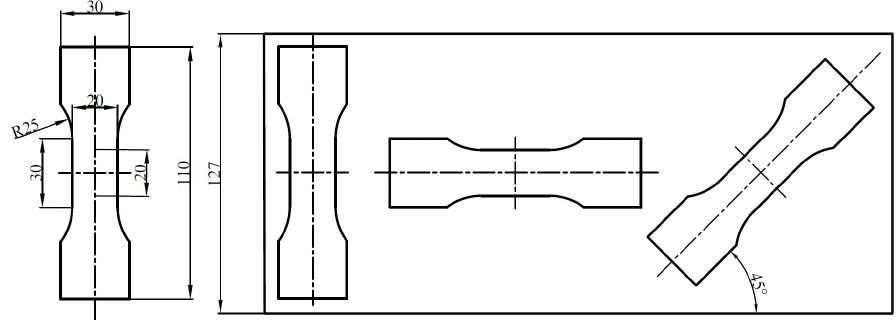
Figure 4. The schematic plot of tensile specimen and cu tt ing directions of strips (Unit: mm).